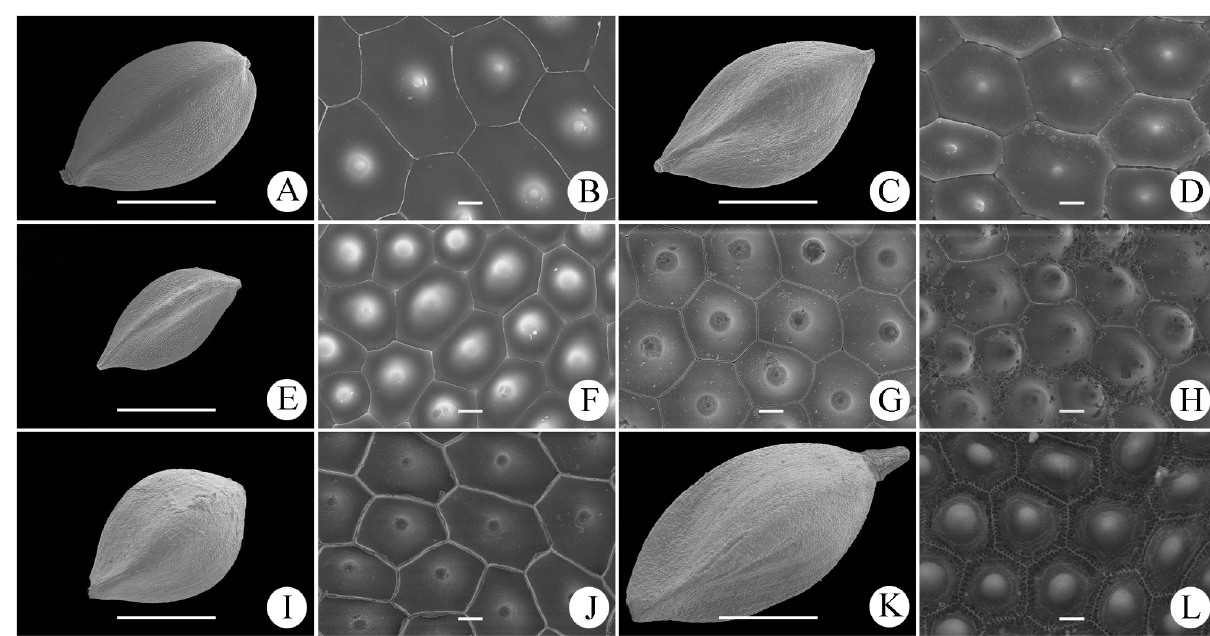
Fig 3. Scanning electron micrographs of the achene micromorphology of seven species in Carex sect. Occlusae . A, B, Carex borealifujianica ; C, D, C . ligulata ; E, F, C . maubertiana ; G, C . hebecarpa ; H, C . pseudoligulata ; I, J, C . polycephala ; K, L, C . poculisquama . A, C, E, I, K, overview and shape (scale bar = 1 mm); B, D, F–H, J, L, epidermal cell shape (scale bar = 10 μ